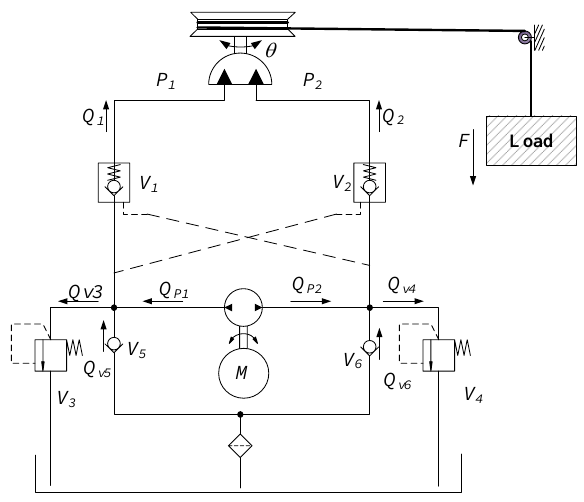
Figure 1. Configuration of a loading system using electro-hydraulic rotary actuator (EHRA).